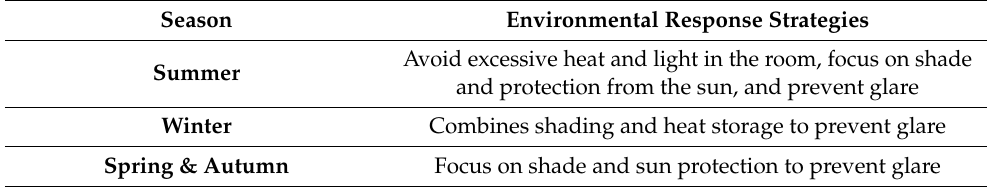
Table 2. Environmental response strategies (self-developed).